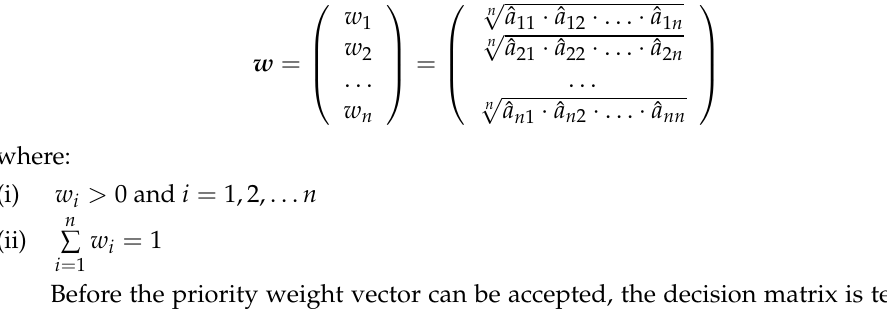
Moderate importance of one over another Very strong importance of one over another Extreme importance of one over